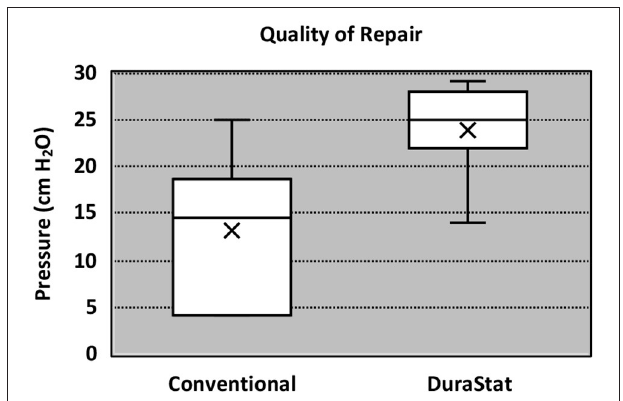
FIGURE 3 | Boxplot of quality of